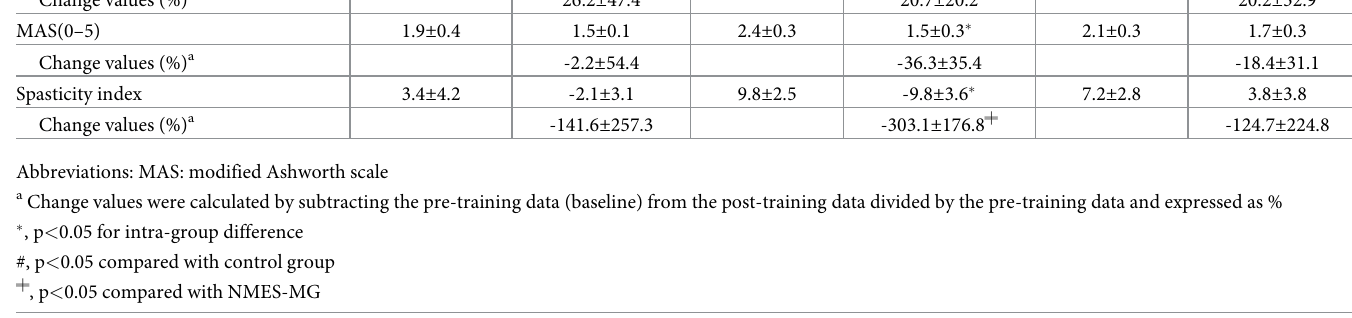
significantly improved after training in all three groups, and no significant group differences in change scores were found. After training, the maximum position of ankle dorsiflexion at heel strike did not signifi- cantly change in all three groups, and there were no significant group differences in change scores detected (Table 5). Compared to the control group, the NMES-TA group showed a sig- nificant improvement in ankle plantarflexion during push off (p = 0.015). For the CV of maxi- mum position of ankle joint at heel strike and in push off, there were neither significant pre- post training differences in all three groups nor group differences in change score detected.